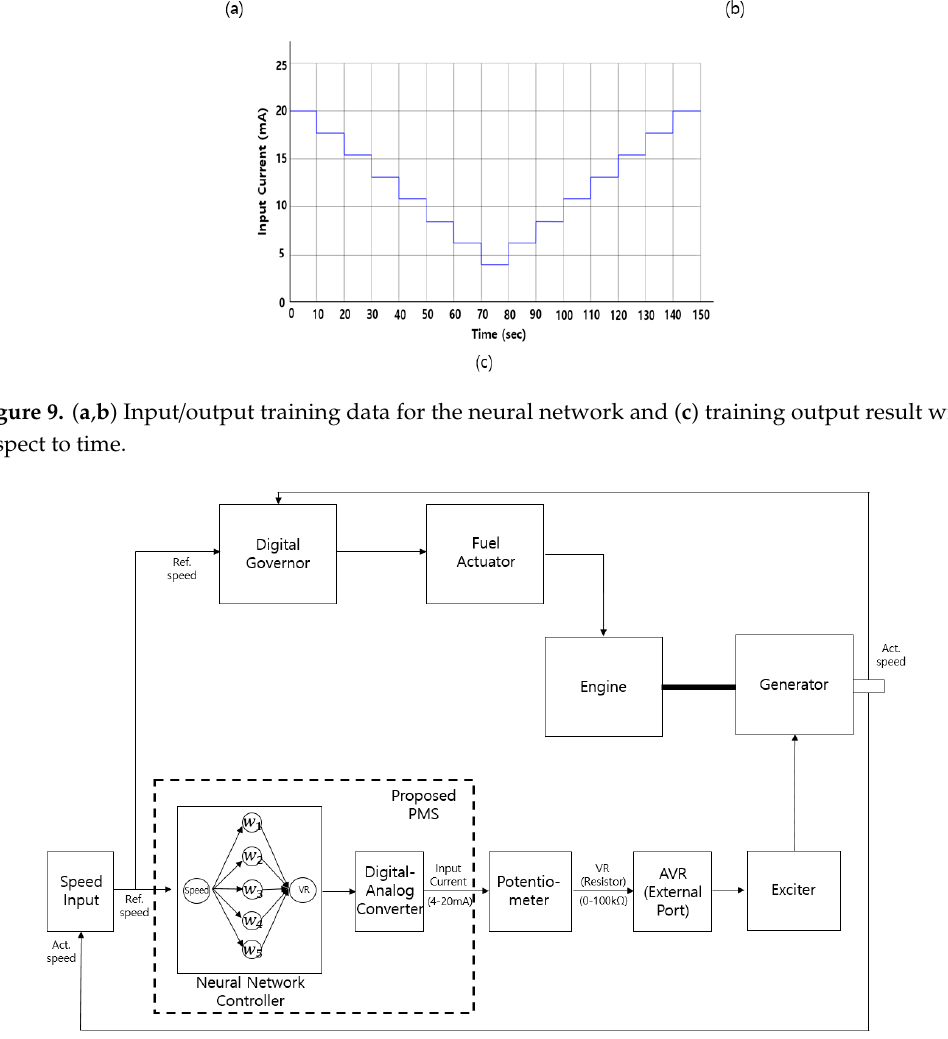
Figure 10. Overall system configuration of the variable speed synchronous generator engine in the reference voltage control method using a neural network .